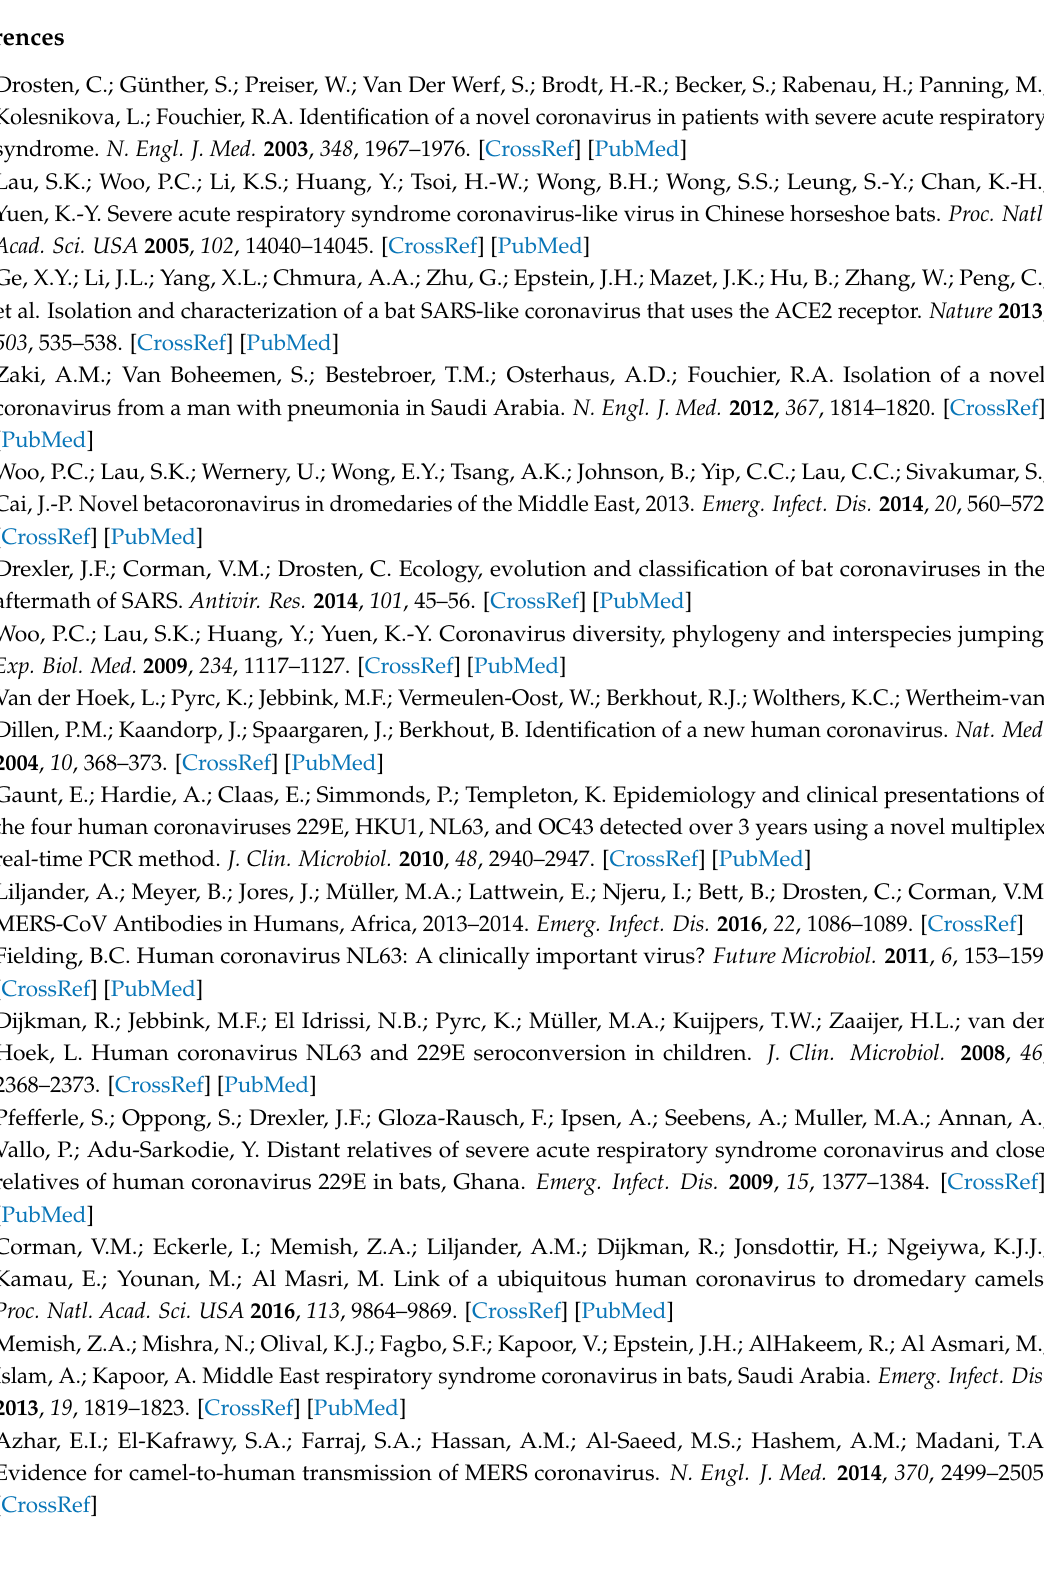
- Calculation: The 630 nm values (plate background) were subtracted from the 450 nm (sample) values ◦ Negative control: secondary antibody only, or better if possible, a negative serum (Should also be negative for other Coronaviruses like HCoV-OC43) ◦ Subtract negative control mean value from the other